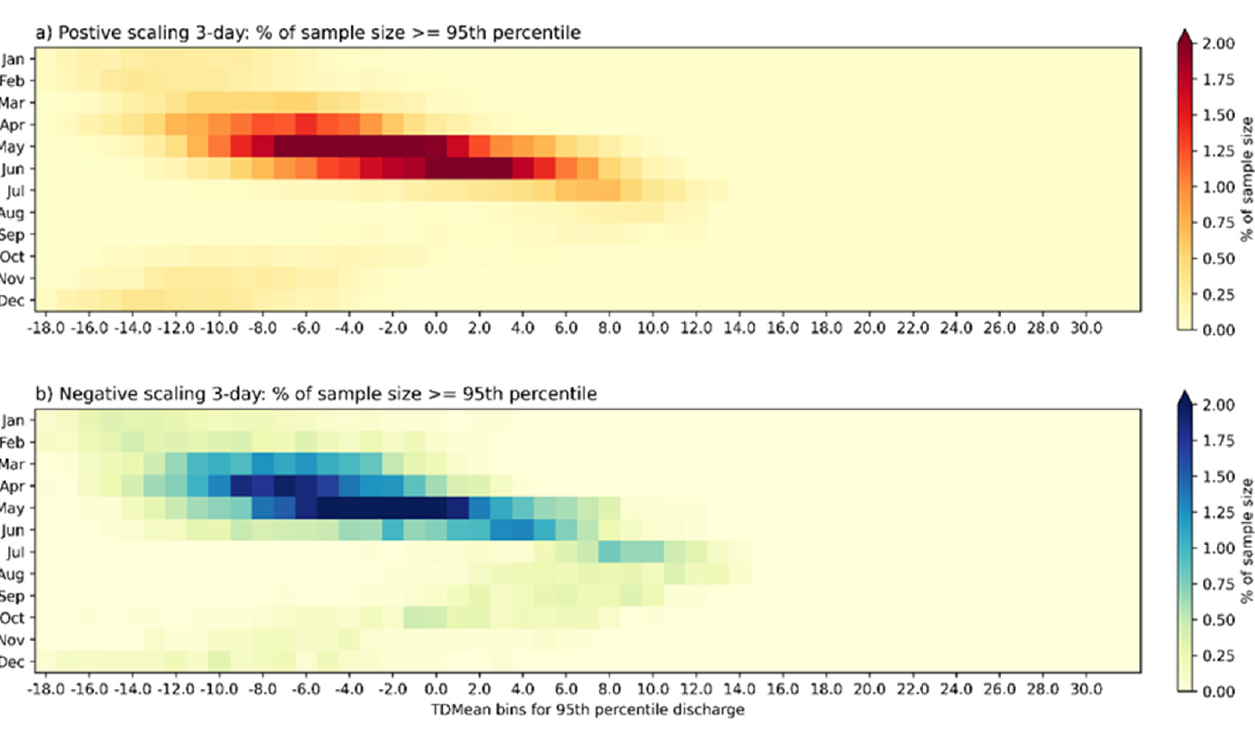
Figure A3. As in Figure 6 except scaling with 3-day running mean dewpoint temperature.